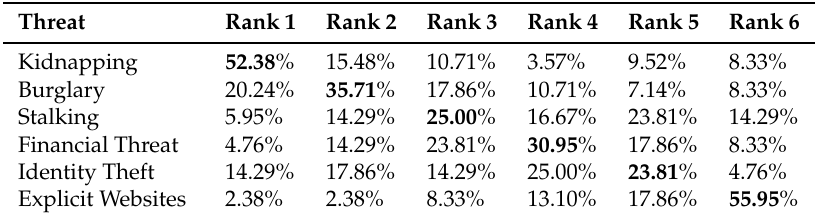
Table 9. Threats are listed in their respective order based on survey results. In each ranking column shows each threat ranking for dangers and their associated vote percentage for that position; the highest vote for each item is highlighted.